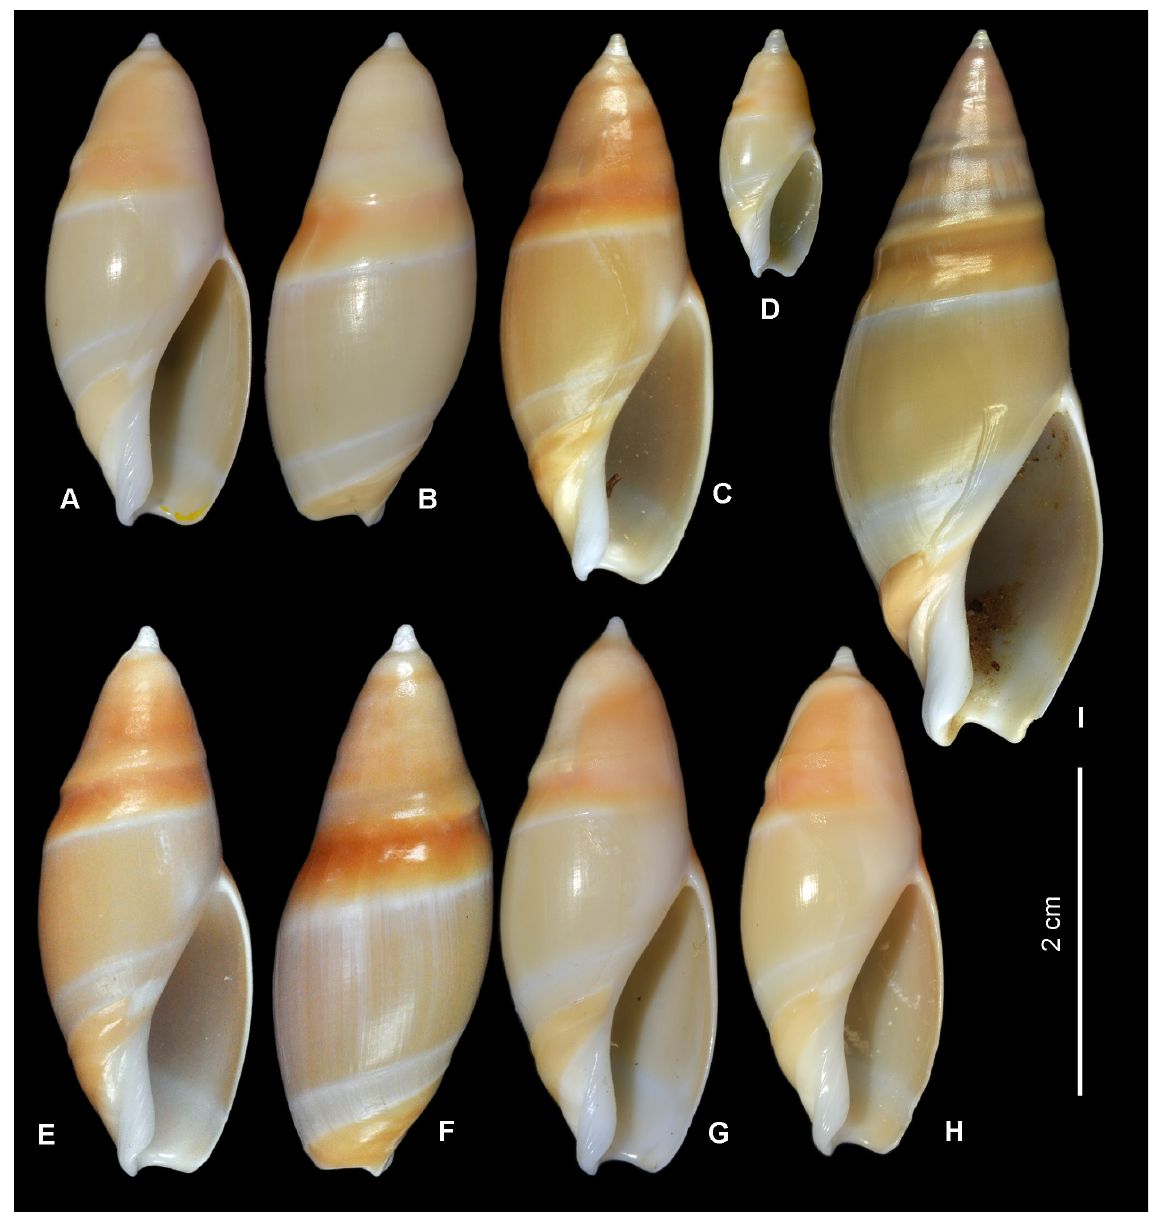
Fig. 6. Amalda hilgendorfi (von Martens, 1897). Southern New Caledonia morph. A–D and E–H belong to two molecularly distinct subclades. A–B . MNHN IM-2007-43664, SL 30.6 mm. C . MNHN IM- 2007-43673, SL 34.2 mm. D . MNHN IM-2009-11964, SL 15.2 mm. E–F . MNHN IM-2007-43671, SL 33.8 mm. G . MNHN IM-2007-43674, SL 34.7 mm. H . MNHN IM-2009-11945, SL 31.6